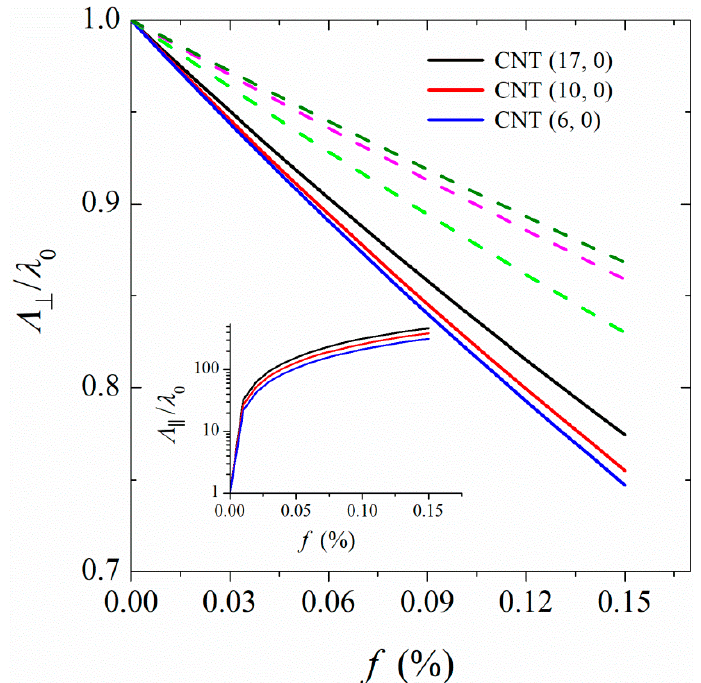
Figure 11. Dependence of the perpendicular thermal conductivities, Λ ⊥ of nanocomposites on the volume fraction of CNTs. The full curves belong to non-linked CNTs and the dashed curves from bottom to up represent the perpendicular thermal conductivities for a nanocomposite containing linked CNTs (17, 0) at linkage fractions 0.021, 0.042, and 0.063. In the inset, the dependence of parallel thermal conductivities, Λ ∥ of nanocomposites on the volume fraction of CNTs is shown.